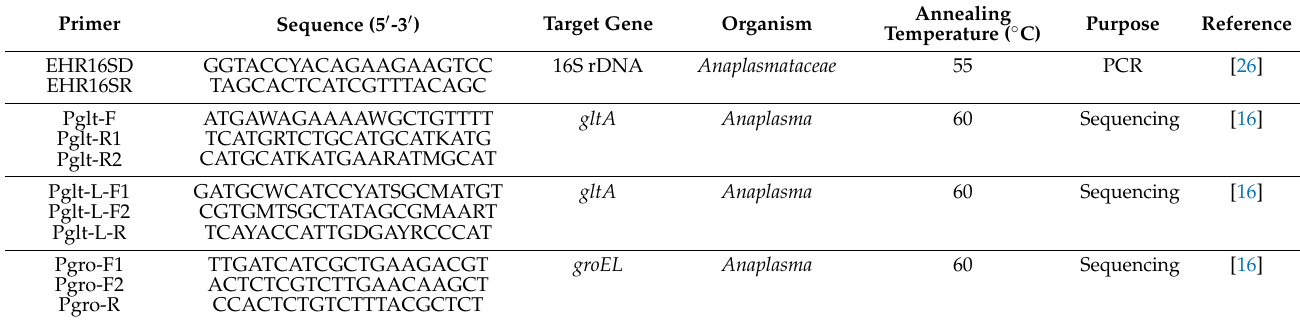
Table 1. Primers used in this study.